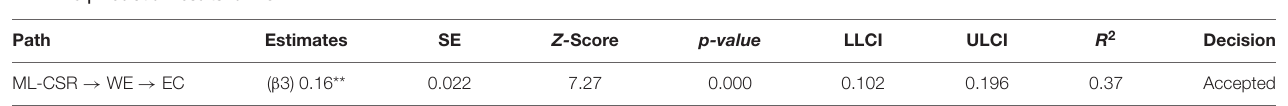
TABLE 5 | Mediation results for